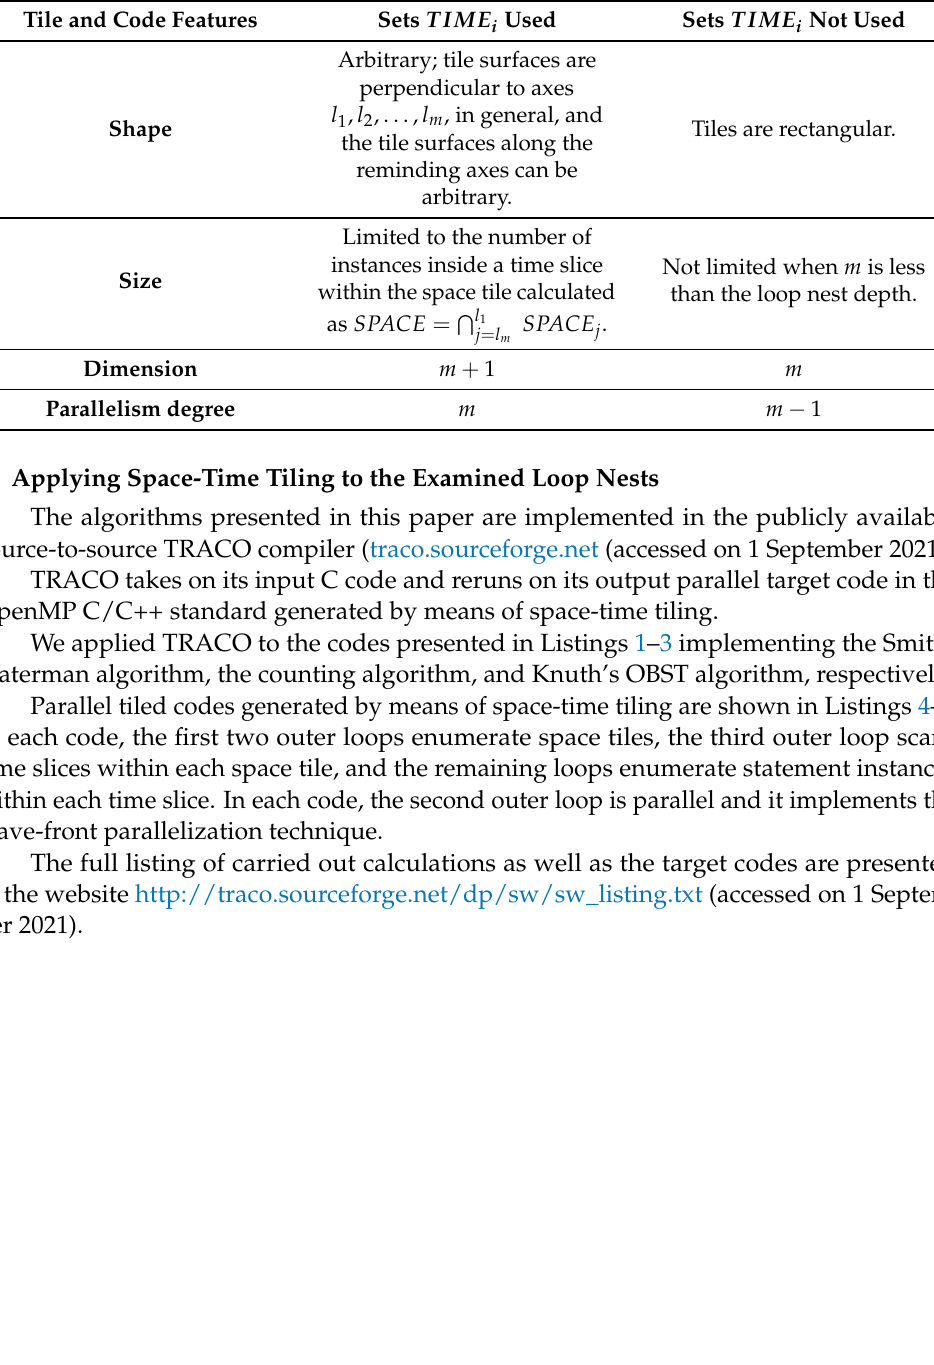
Table 1. Features of target tiles and target code when the number of positive elements of a common direction vector is m